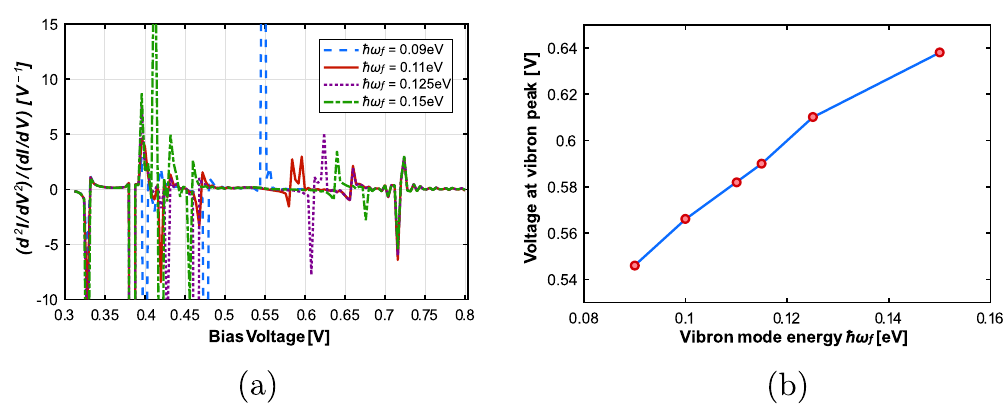
Figure 4. Nanowire RTD IET spectrum, and, IETS peak position (in voltage) vs vibron energy for different values of vibron energy and a fixed bulk phonon mode energy ( ħ ω = 0.175